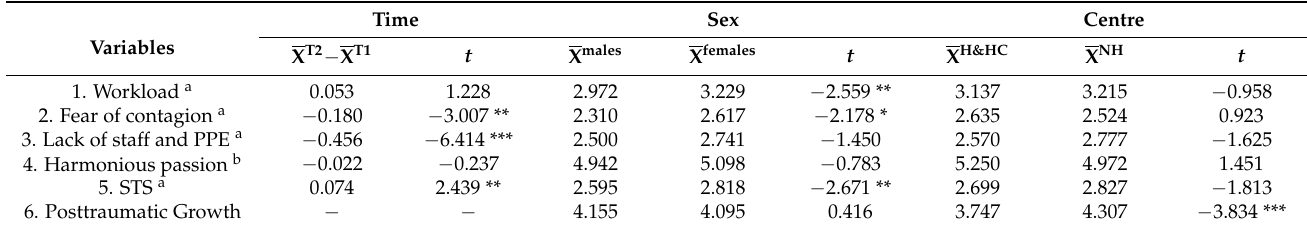
Table 3. Significant differences among the interested variables concerning time (the first and the second wave of COVID-19 crisis), sex and center.